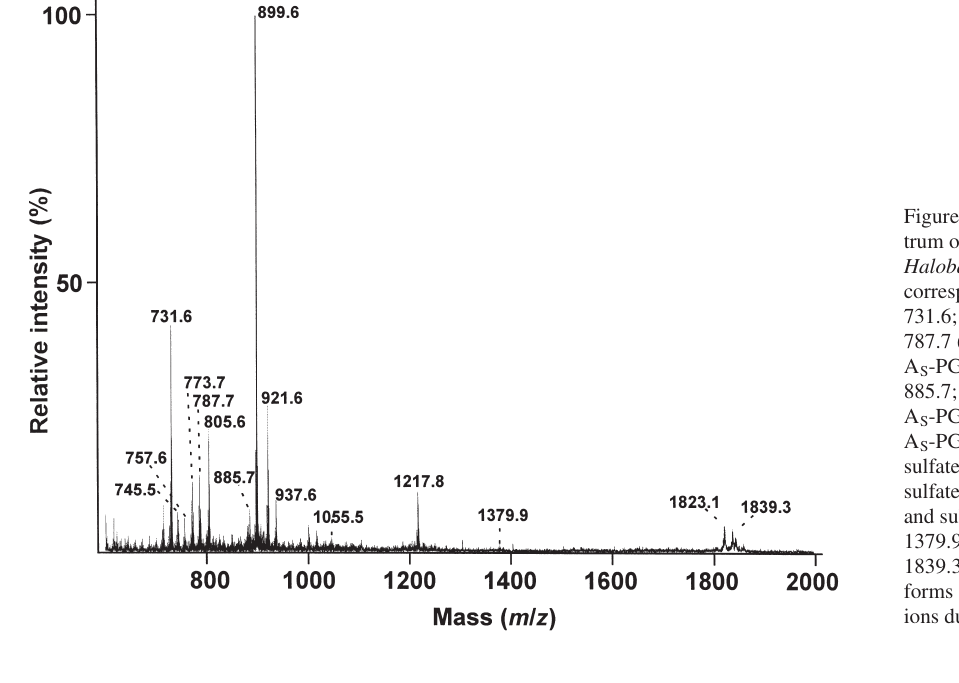
Figure 1. Negative-ion FAB MS spec- trum of the total polar lipids from Halobacterium halobium . Assignments correspond to M – signals: A S -P, m / z = 731.6; m / z = 745.5, 757.6, 773.7 and 787.7 (see text); A S -PG, m / z = 805.6; A S -PG-sulfate plus A S -PGP, m / z = 885.7; A